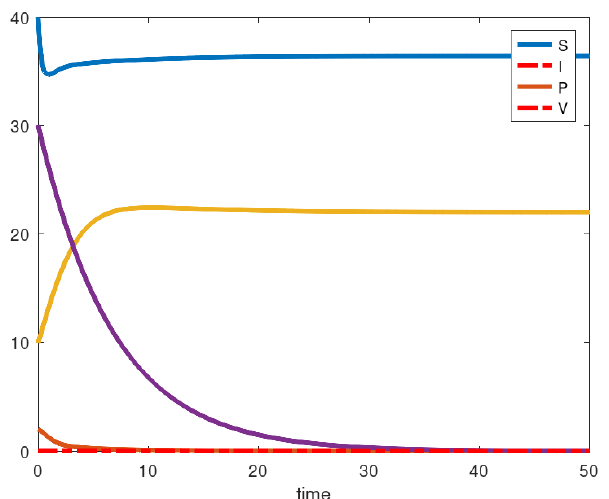
Figure 5. (cid:98) E 4 can be attained with the parameters in (21), (26) and the initial conditions (22),